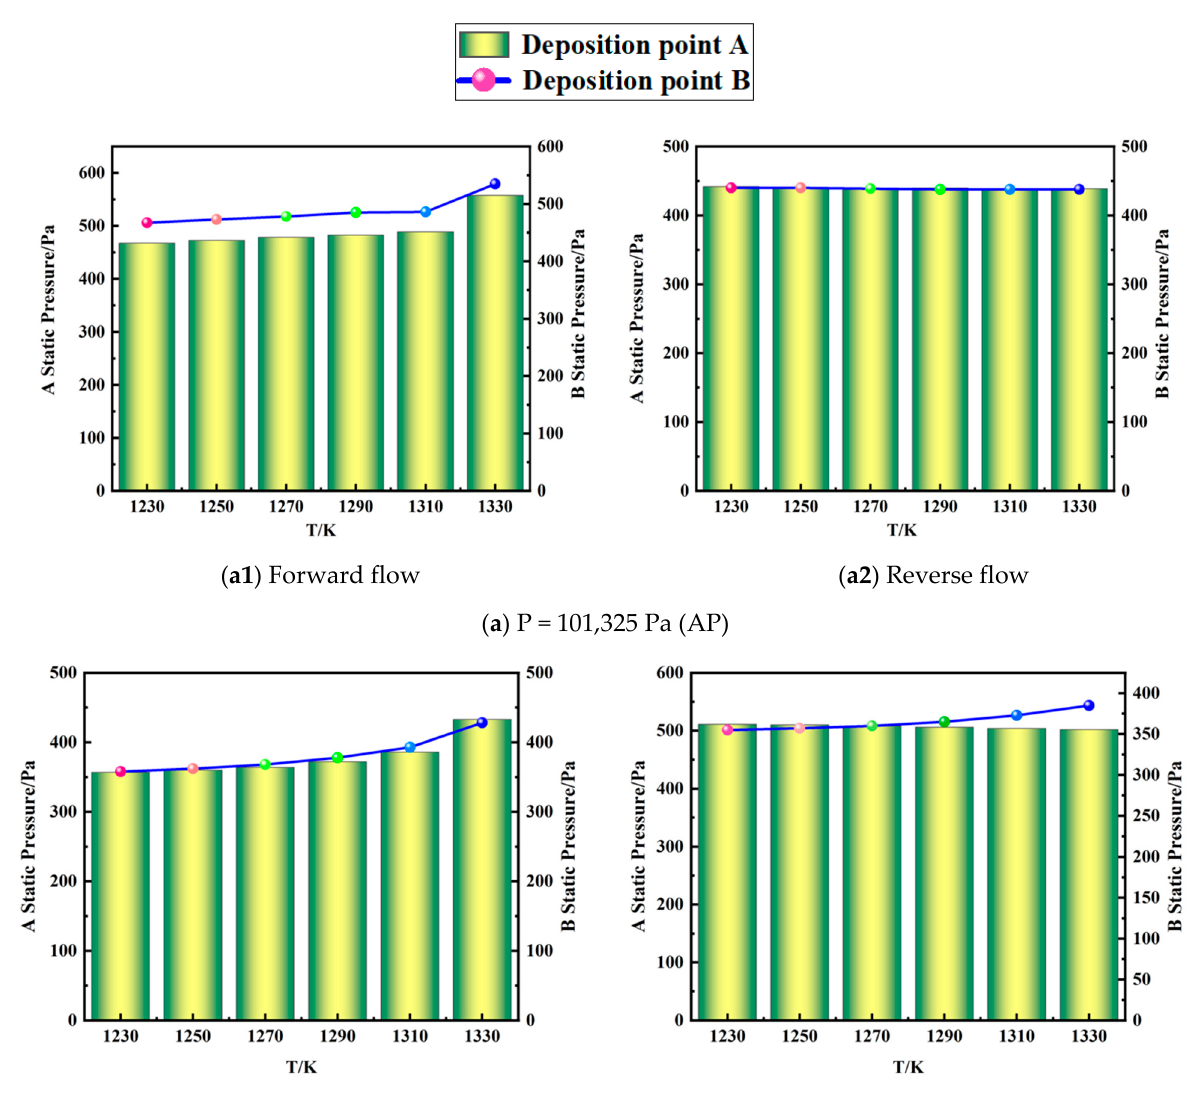
Figure 8. Atmospheric and low pressure drop with different temperatures in forward( a1,b1 ) and reverse( a2,b2 ) flow: ( a ) AP (101,325 Pa) and ( b ) LP (660 Pa).